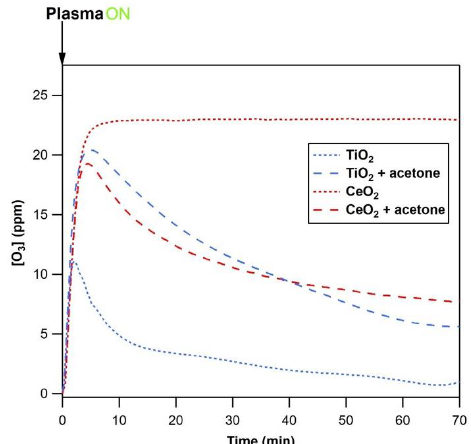
Figure 5. Temporal evolution of the difference between inlet and outlet ozone concentrations in the U-shape reactor under 5 different conditions: (i) Without material in the U-shape reactor, i.e., ozone mixing curve. (ii) With 100 mg fresh CeO 2 . (iii) With 100 mg CeO 2 covered by 2.2 µmol/m 2 of acetone. (iv) With 200 mg fresh TiO 2 . (v) With 200 mg TiO 2 covered by 2.6 µmol/m 2 acetone. Flow rate = 750 mL/min, During the ozonation induced by non-thermal plasma [O 3 ] 0 = 22 ppm for CeO 2 , [O 3 ] 0 = 24 ppm for TiO 2 , acetone is preadsorbed according to the protocol described in the previous adsorption section.